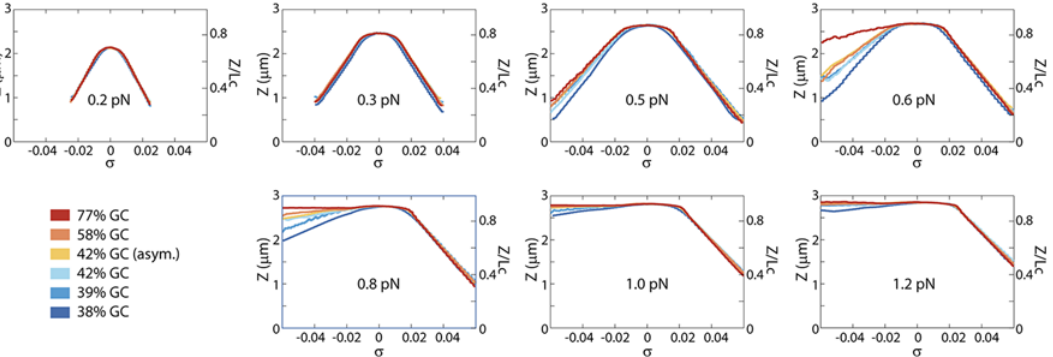
Fig 2. DNA extension as a function of supercoiling density. For six DNA sequences, the DNA extension Z is measured as function of the applied supercoiling density at varying forces between 0.2 and 1.2 pN. The shown curves are averages of a large number of individual molecules (see Materials and Methods). At 0.3pN and below all rotation curves are symmetric and applied supercoiling is absorbed into plectoneme formation. Increasing the applied stretching force results in less symmetric rotation curves. At intermediate forces of 0.6 and 0.8pN the sequence-dependent effect of competition between DNA melting and plectoneme formation is most pronounced. At 1.2pN all sequences show an asymmetric rotation curve: applied negative supercoiling is absorbed into DNA melting, and applied positive supercoiling is absorbed into plectonemes. For ease of comparison with other work, on the right axis the extension is presented relative to the contour length of the molecule (3.33 μ m). The noise in the extension ( std of Z ) of the molecules for these curves are shown in S2 Fig.